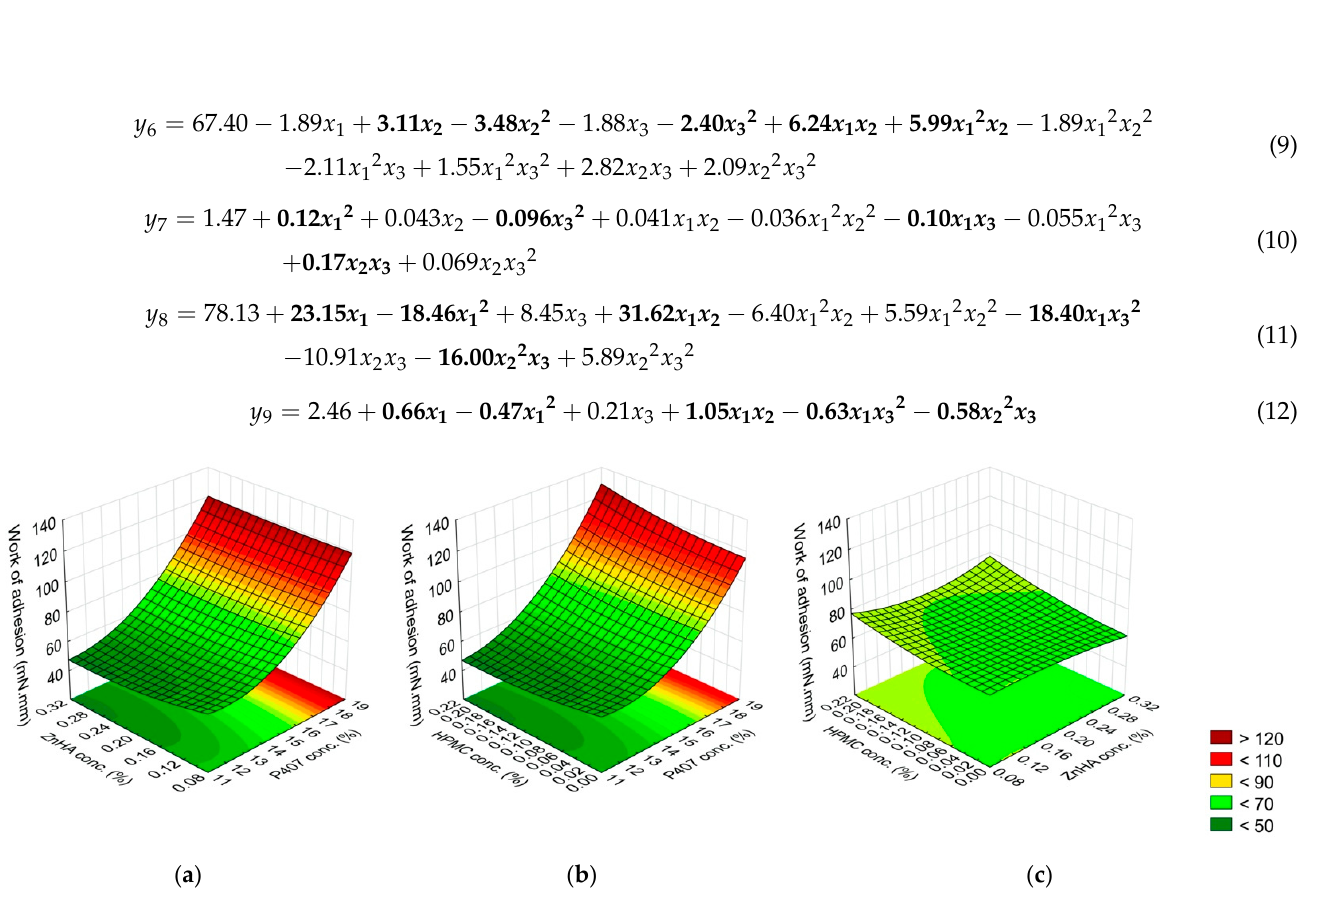
Figure 5. Effect of the composition on the adhesive work: ( a ) P407 and ZnHA concentrations, ( b ) P407 and HPMC concentrations, ( c ) ZnHA and HPMC; (the 3rd factor is at 0 level in each case). The released amount of DXM was determined by the ZnHA concentration (L, Q), the HPMC concentration (Q), and the interaction of HPMC (L) with the P407 concentration (L